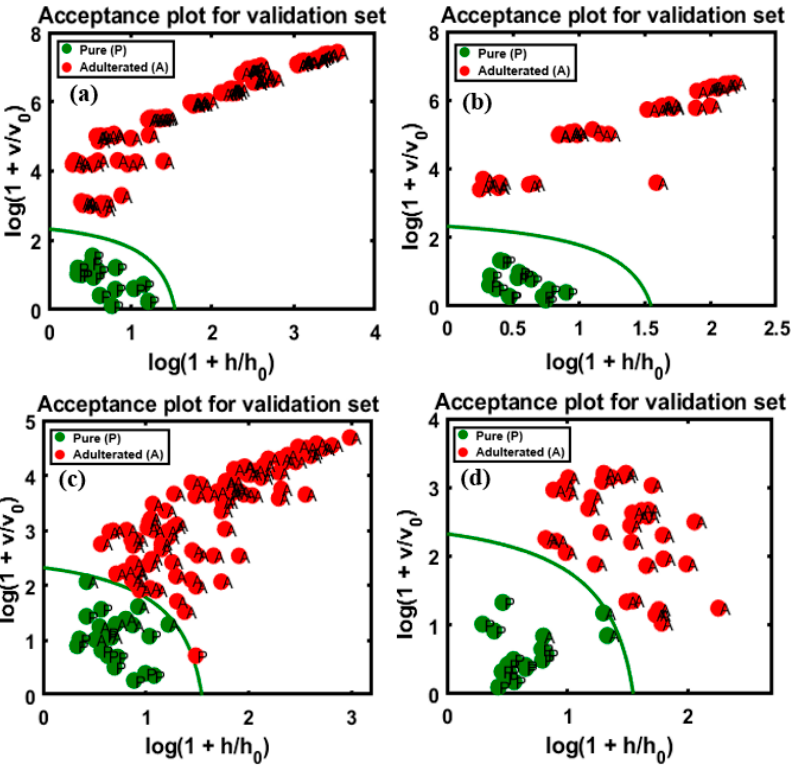
Figure 10. Predictive performance of the model based on the chi-square test determined by applying the DD-SIMCA method to the four different FT-NIR validation data sets: apricot-adulterated almond powder of the ( a ) 1st and ( b ) 2nd varieties, peanut-adulterated almond powder of the ( c ) 1st and ( d ) 2nd varieties.